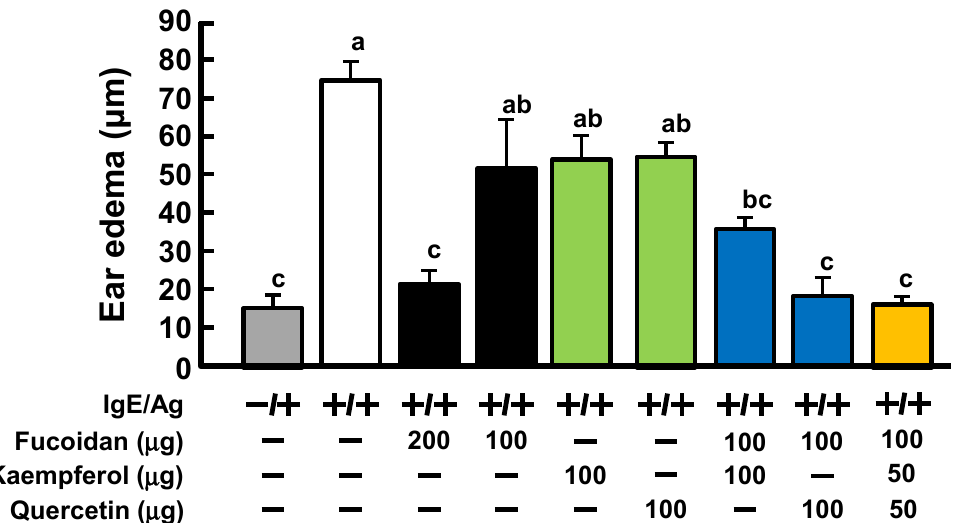
Figure 3. Anti-allergic activity of combination with quercetin or/and kaempferol in PCA reaction. Balb/c mice were divided into 9 groups and were orally administered fucoidan alone, kaempferol alone, quercetin alone, fucoidan + kaempferol, fucoidan + quercetin, and fucoidan + kaempferol + quercetin. After 4 days of administration, the PCA reaction was performed. Values represent the means ± SE of 5 mice in each group. Different letter (a, b, c) means the significant differences ( p < 0.05; Tukey-Kramer test).